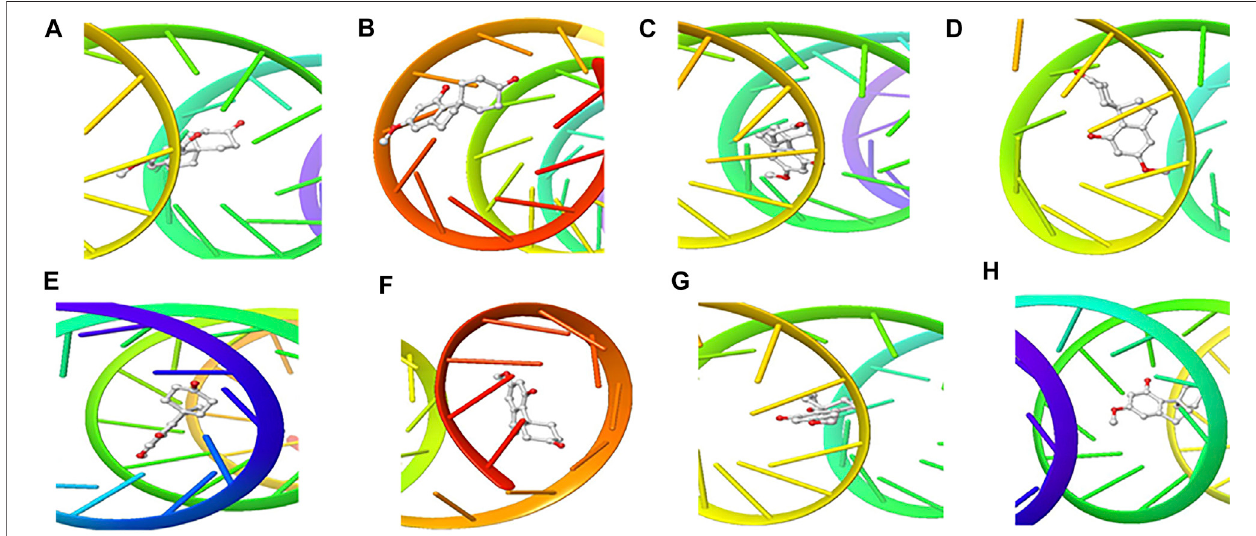
FIGURE 6 | 3D Interaction of Cannabispiran with Initiation and Termination Sequence of the Viral Proteins. A (cid:1) Nucleocapsid Phosphoprotein Translation Initiation Site;B (cid:1) EnvelopeProteinTranslationInitiationSite;C (cid:1) EnvelopeProteinTranslationTerminationSite;D (cid:1) NucleocapsidPhosphoproteinTranslationTerminationSite; E (cid:1) ORF1ab Translation Initiation Site; F (cid:1) ORF1ab Translation Termination Site; G (cid:1) Surface Glycoprotein Translation Termination Site; H (cid:1) Surface Glycoprotein Translation Initiation Site.